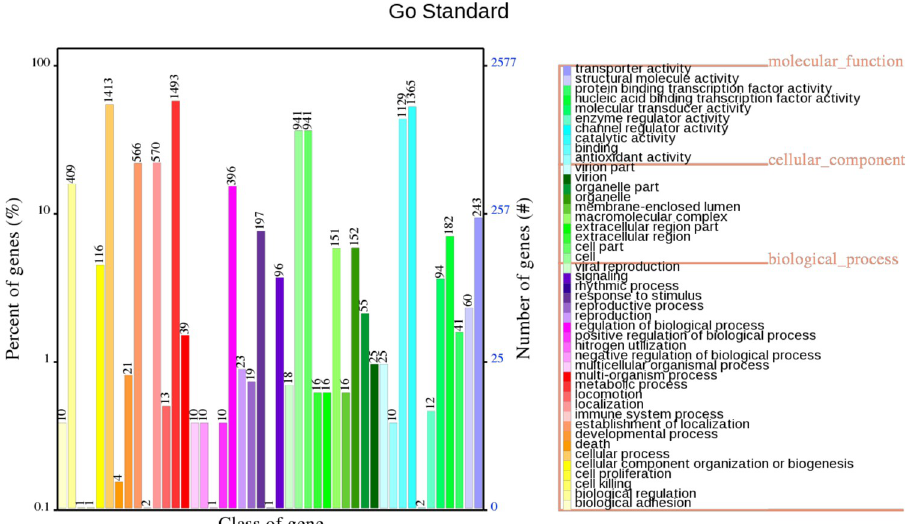
Fig 2. GO annotation of VJR422. The horizontal axis displays the GO function class for the annotated genes. The right vertical axis is the gene number, and the left vertical axis is the percentage of gene number annotated in all the coding